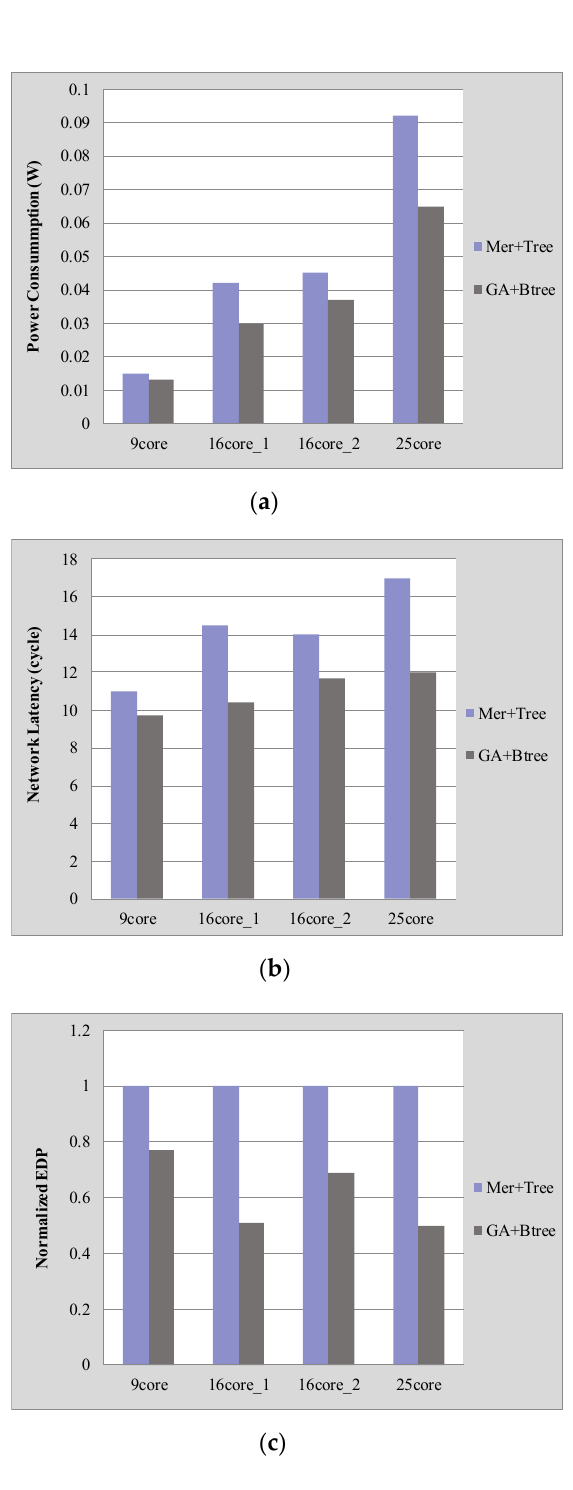
Figure 7. Comparison of performances under the same NoC platform: ( a ) Power consumption comparisons; ( b ) Latency comparisons; ( c ) EDP comparisons.